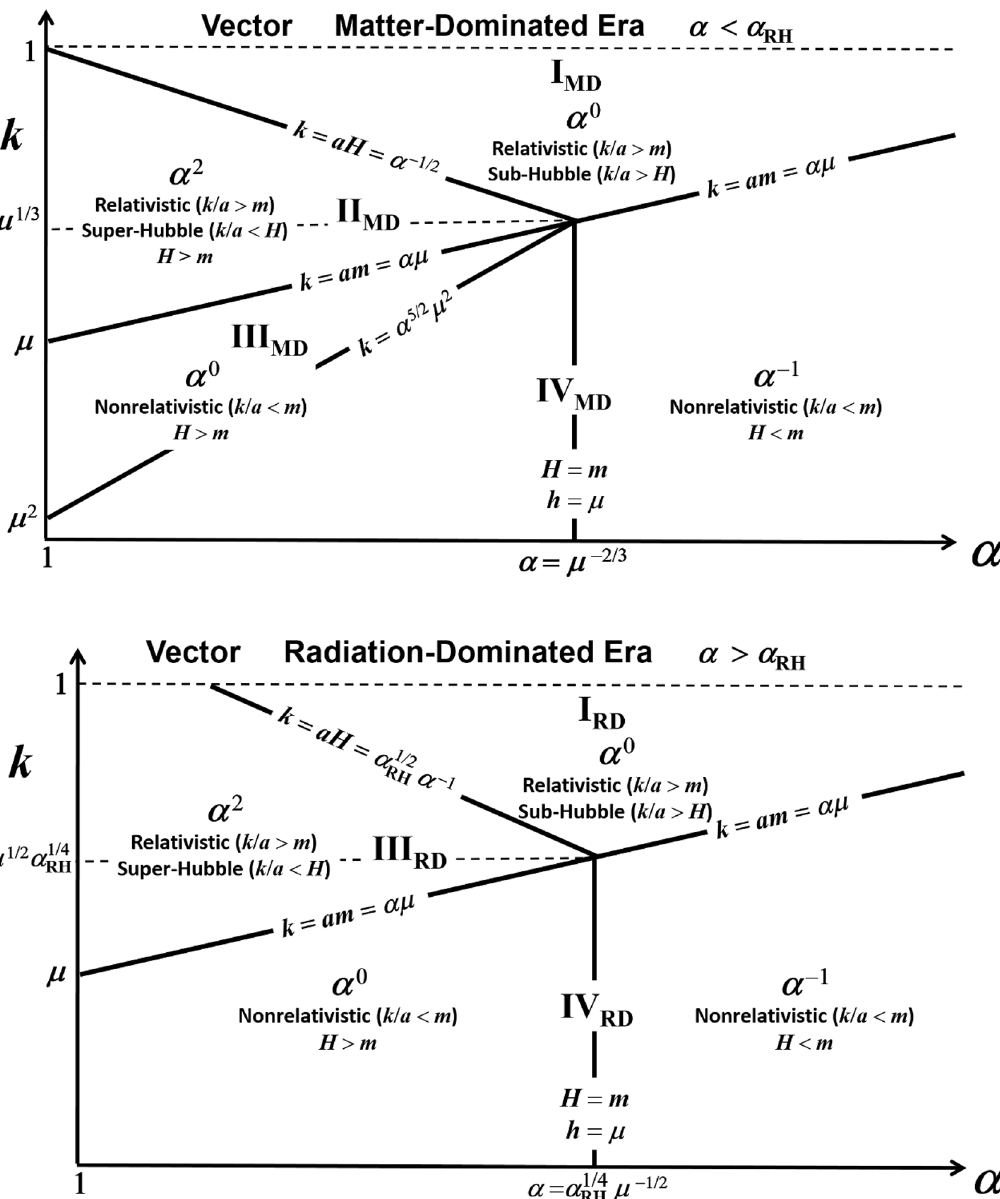
Figure 5 . Regions in the α – k plane for evolution in the MD phase (upper) and the RD phase (lower). In different regions we indicate the scalings of | χ k | 2 with α . Note that k = µ 1 / 2 α 1 / 4 will be RH larger than unity (hence off the graph) if α RH > µ − 2 . In the RD phase, α RH will be smaller (larger) than α 1 / 4 µ − 1 / 2 if α RH is smaller (larger) than µ − 2 / 3 . For both MD and RD, the line denoted RH k = αµ is the line delineating the nonrelativistic ( k < am ) and the relativistic ( k > am ) regions. In MD the line k = α − 1 / 2 and in RD the line k = α − 1 α 1 / 2 is the line denoting k = aH ; above the lines RH the mode is sub-Hubble-radius ( k > aH ), while below the line the mode is super-Hubble-radius ( k < aH ). The values of α = µ − 2 / 3 for MD and α = α 1 / 4 µ − 1 / 2 for RH are the values of α when RH H = m . To the left of the lines H > m , and to the right H < m